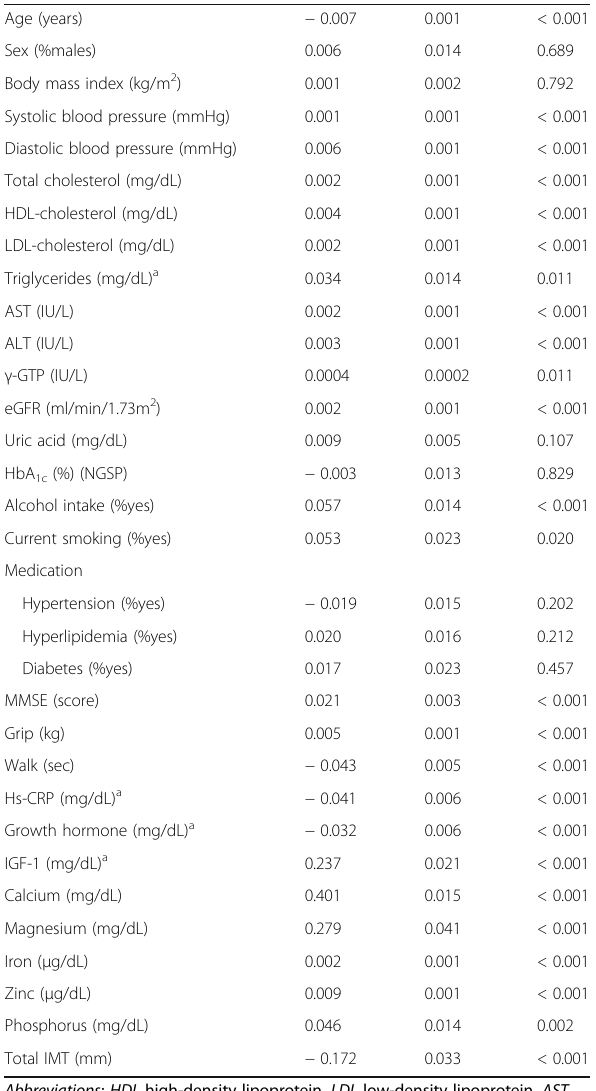
Table 3 Univariate analysis for serum albumin Table 4 Multiple stepwise regression analysis for